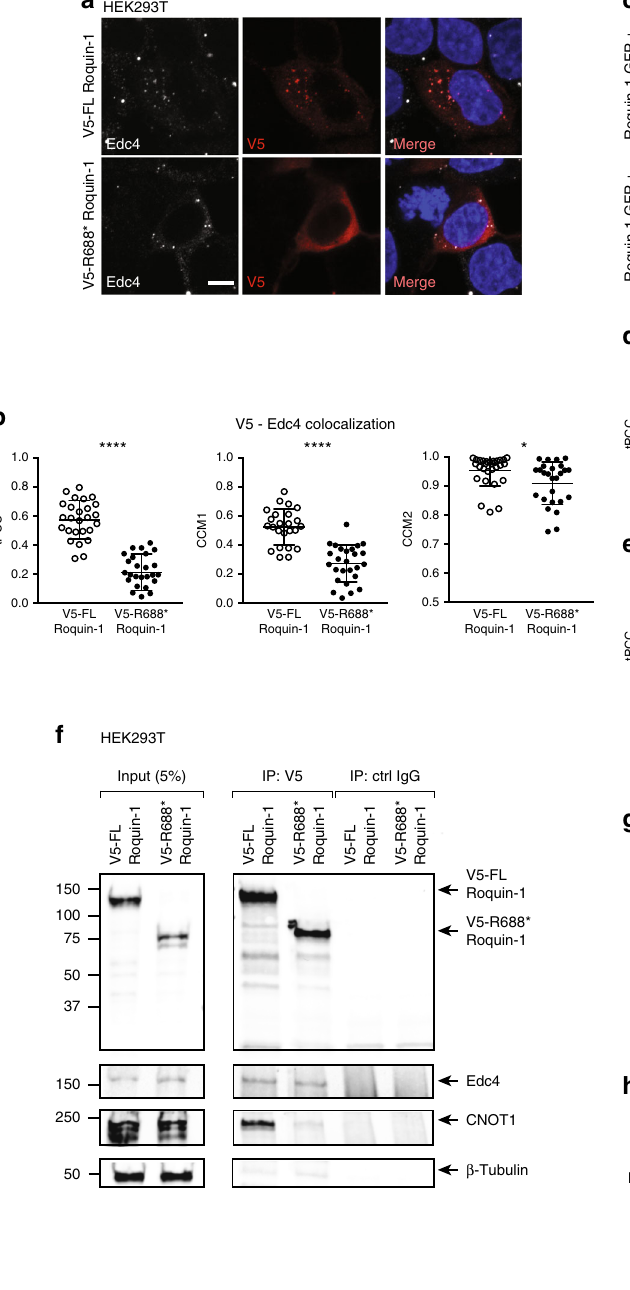
R688* variant (Supplementary Table 2). Murakawa et al.